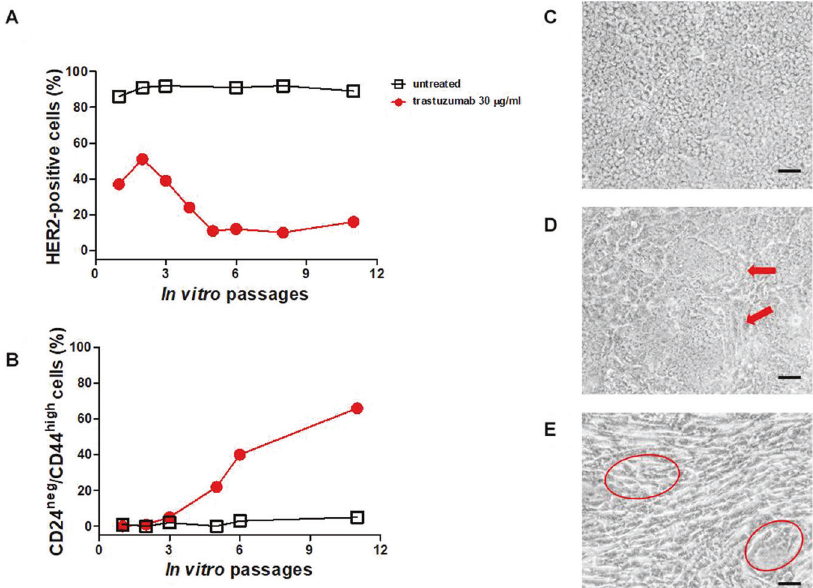
Fig. 4 Phenotypic evaluation of MamBo43HER2 labile cells maintained in continuous culture with and without trastuzumab. A , B Cyto fl uorimetric analysis of cell culture at different time points in terms of number of in vitro passages. Black open square, untreated cells; red solid circle, cells cultured in presence of 30 µg/ml of trastuzumab. A Percentage of HER2-positive cells; B Percentage of cells with the staminal phenotype CD24 negative /CD44 high . C – E Micrographs of untreated cells after 4 in vitro passages C or trastuzumab-treated cells after 4 in vitro passages D and 8 in vitro passages E . Untreated cells are uniformly polygonal, whereas trastuzumab-treated cells show spindle-like area (indicated by the red arrows) after 4 in vitro passages. After 60 days of treatment (8 in vitro passages), the spindle-like population takes over and only a few islets of polygonal cells remain (indicated by the red circles). Black bar corresponds to 200 and platelet activation. The down-regulated genes in HER2- negative cells are involved in protein localization to plasma membrane and cell periphery. The main knots of interaction, analyzed by STRING, among genes products up-regulated in HER2-negative cells (Fig. 6C) are known to be down-regulated in HER2-positive breast cancer, or have, in turn, been associated with triple-negative breast cancers, such as Fn1 and Vim. Others, such as Vegf-a, Ptgs2, and Hif- α , were linked to the up-regulated pathway of angiogenesis. Furthermore, Dcn, Cav1, Cdkn1a, Myc, Qsox1, and Pdgfr-b are known for their role in promoting tumor-cell aggressiveness, EMT and sustaining the proliferation of mesenchymal cells. The EMT-associated pro fi le of cells that lack HER2 expression was also con fi rmed by Real-Time PCR (Supplementary Fig. S5). Down-regulated genes in HER2- negative cell lines (Fig. 6D) are directly linked to HER2 over- expression and HER2-positive breast cancers ( e.g ., Stat, Ptpn1, Pak1, Efnb1). Other genes, such as Cecam1, Jup, Cdh1, Notch1, and Kit, are associated with polygonal shape and growth in a monolayer of closely interacting cells or luminal differentiation (Sptan1) of HER2-positive cell lines. In order to identify the speci fi c traits of tumor cells showing a tendency to lose HER2, we compared the molecular pro fi les of the MamBo89HER2 stable and MamBo43HER2 labile cell lines (Fig. 6E – G). The comparison highlighted 225 differentially expressed genes that are involved in metabolic processes, angiogenesis, biosyn- thetic processes, phosphorylation and cell motility. These genes clustered in pathways related to focal adhesion, glutathione metabolism, and TNF signaling pathway (Fig. 6E, F). STRING analysis evidenced networks of genes involved in cell plasticity ( e.